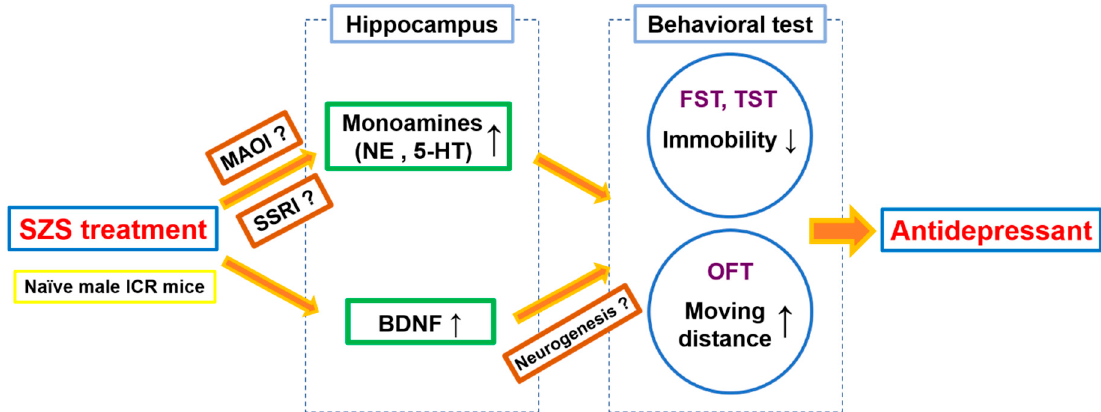
Figure 6. A pictogram illustrating the hypothesized mechanism of action for SZS as an antidepressant. SZS: Semen Ziziphi Spinosae.